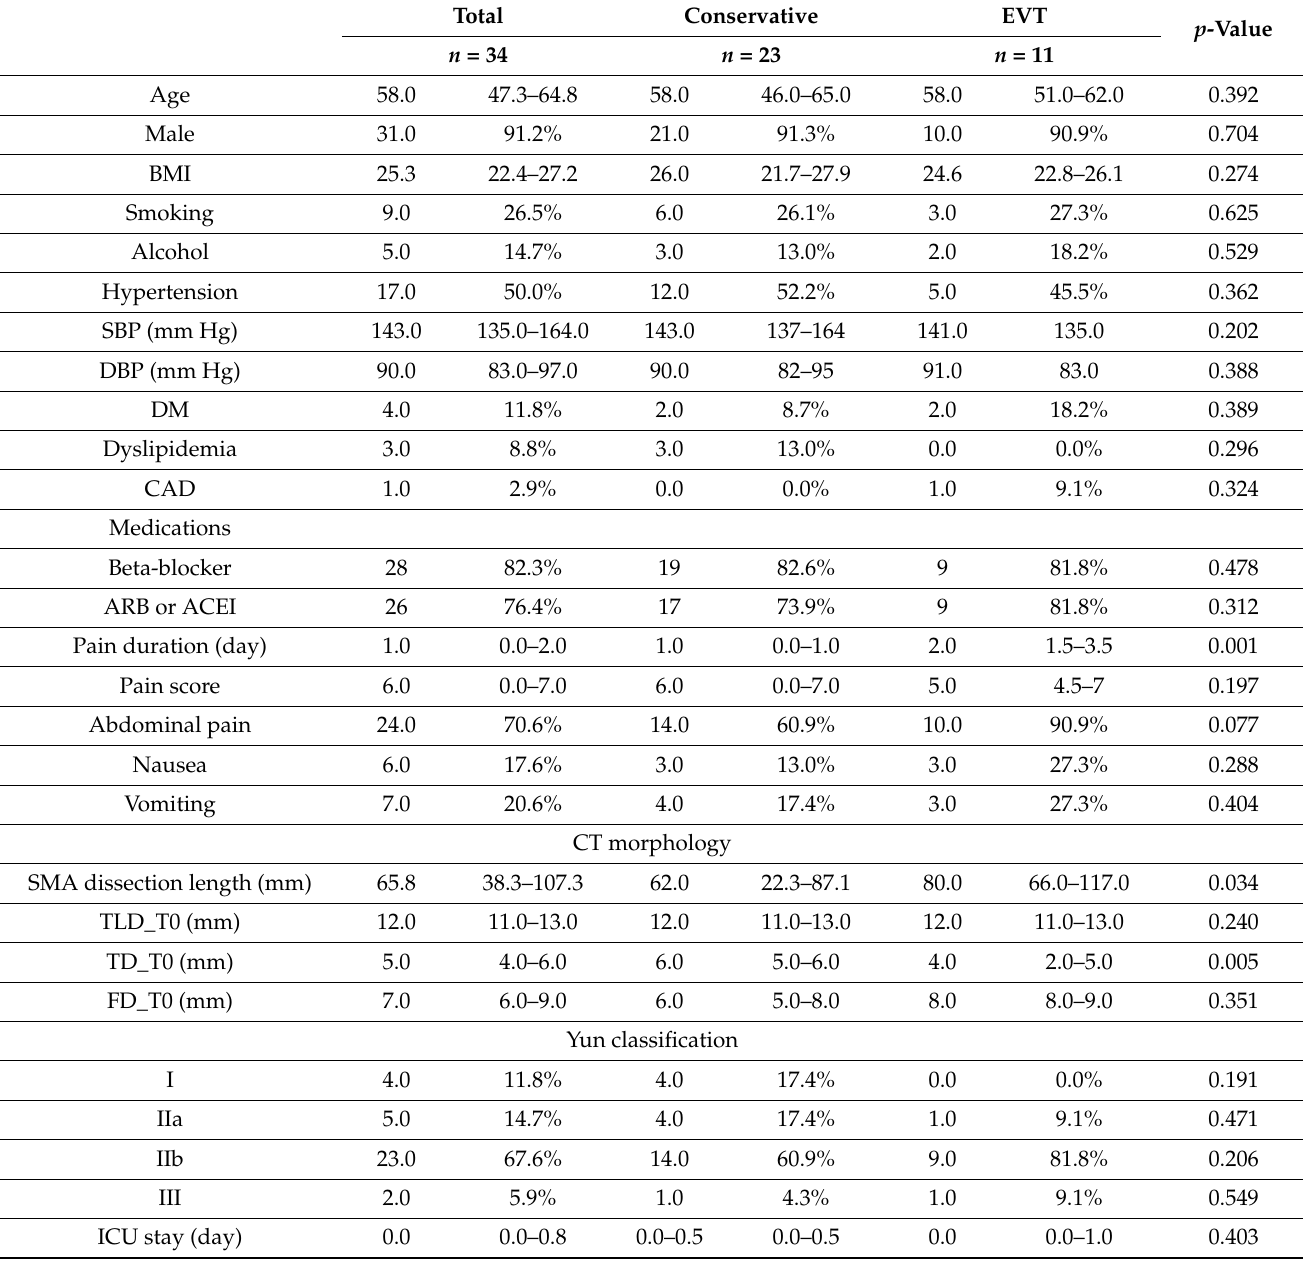
Table 1. Patient demographics, CT scan morphology, and follow-up